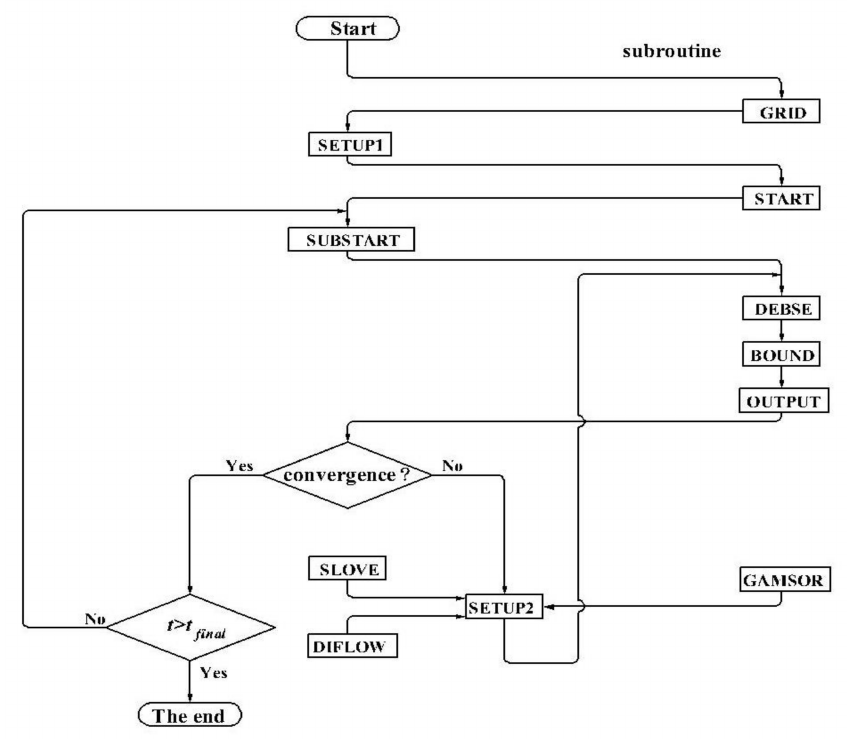
Figure 4. The flowchart of the computation program.